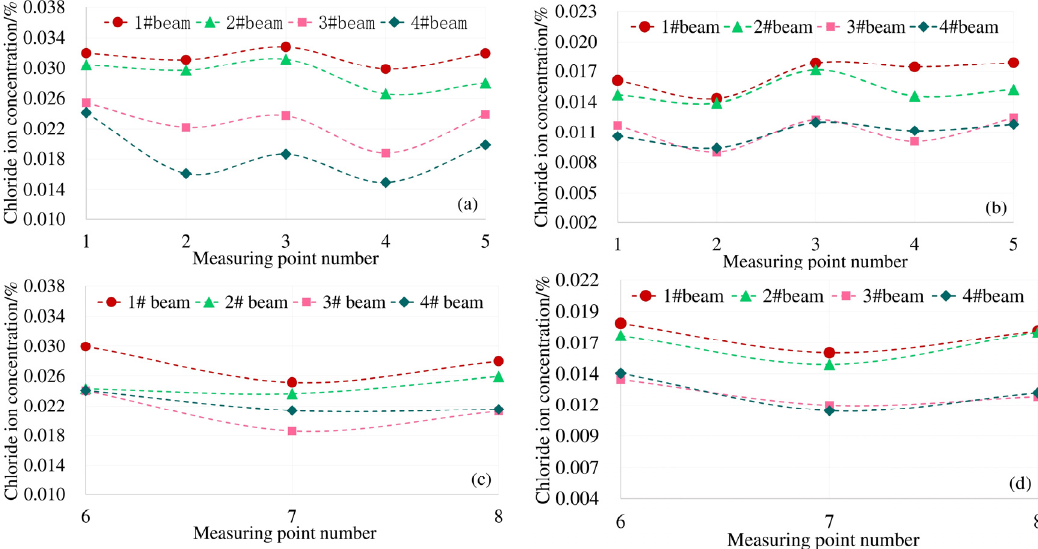
Figure 7. Chloride ion distribution on top and bottom plates affected by shear lag effect of box beam, ( a ) Concentration on the roof at 4 mm; ( b ) concentration on the roof at 7 mm; ( c ) concentration on the floor at 4 mm; ( d ) concentration on the floor at 7 mm.